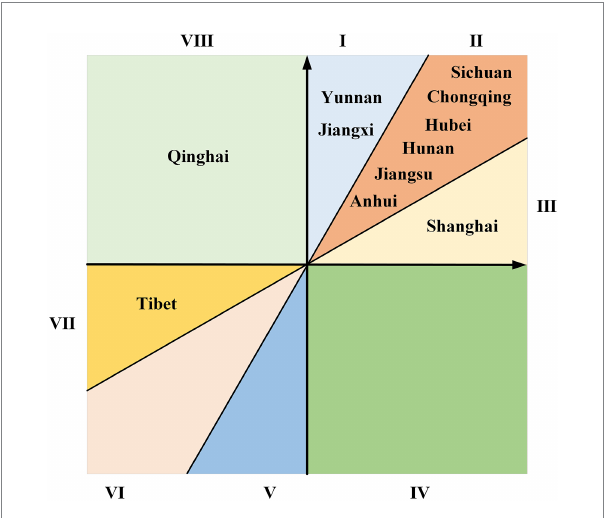
FIGURE 11 The decoupling state in different provinces from 2010 to